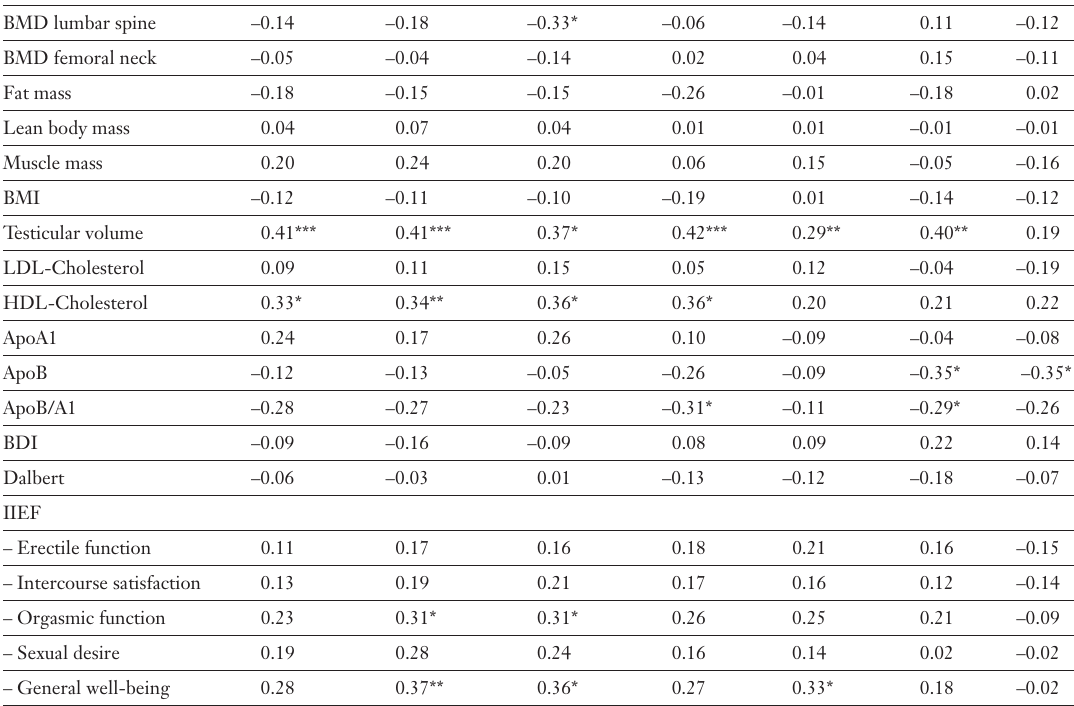
Correlation coeffi- cients (R) between testosterone levels and clinical